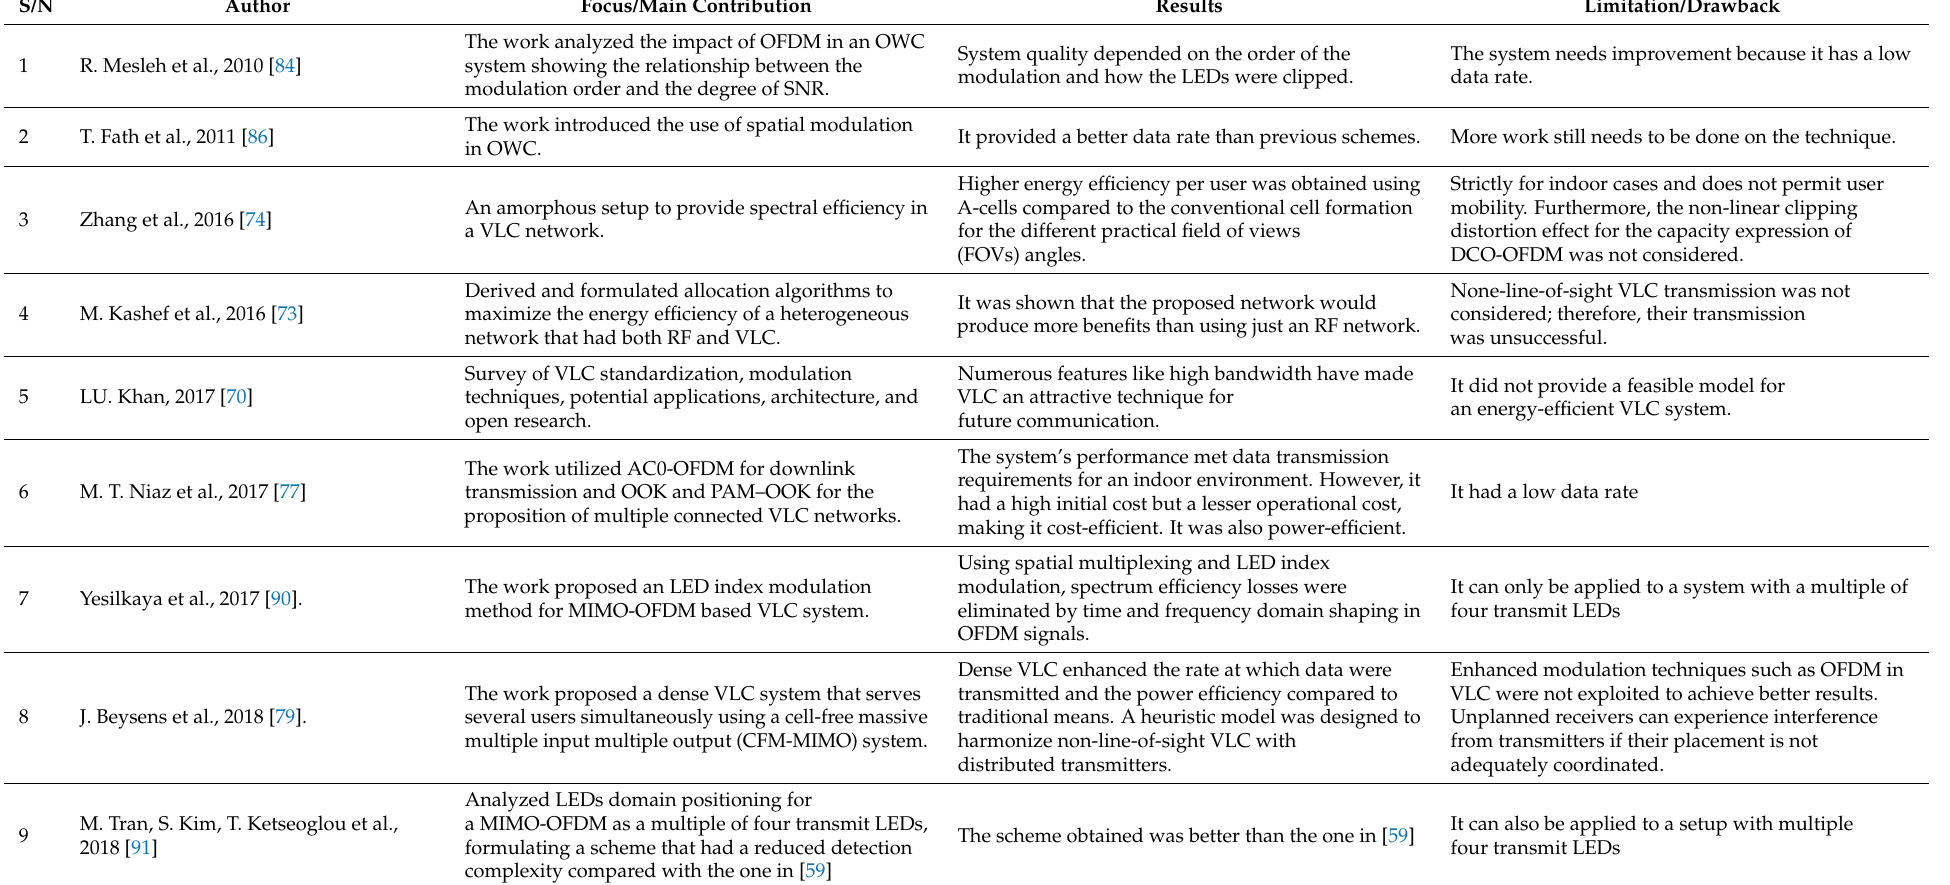
Table 3. Summary of work utilizing different optical wireless communication modulation